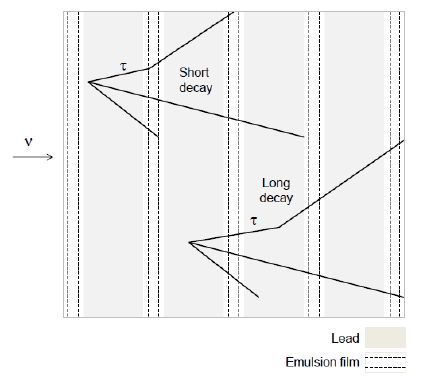
Figure 1. Detectable τ decay topologies: the decay is defined as short or long depending on whether it occurs in the same lead plate where the neutrino interacts or downstream of